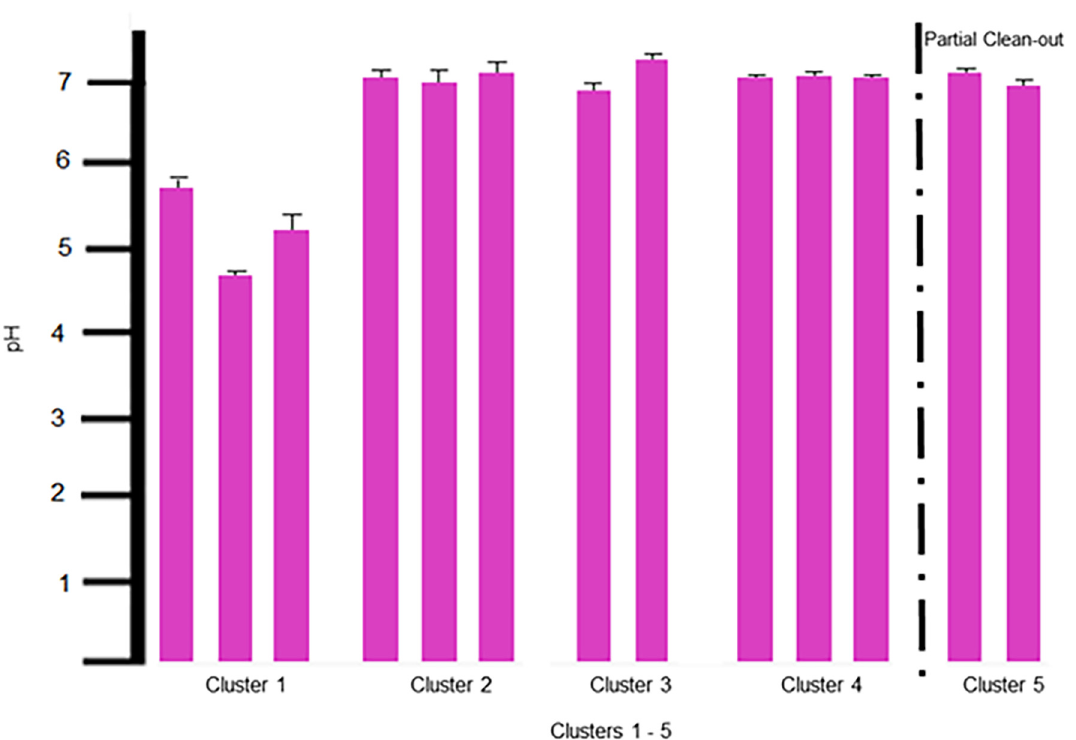
Fig 4. Mean values for soil pH. Mean values for soil pH with standard deviation error bars are shown in this graph. In order from left to right on the graph is Cluster 1: Native, Pad and Flock1; Cluster 2: Flock 2, 10 and 11; Cluster 3: Flocks 3 and 4; Cluster 4: Flocks 5, 6, and 7; and Cluster 5: Flocks 8 and 9. The partial clean-out which occurred between Flock 7 and 8 is marked by a dashed